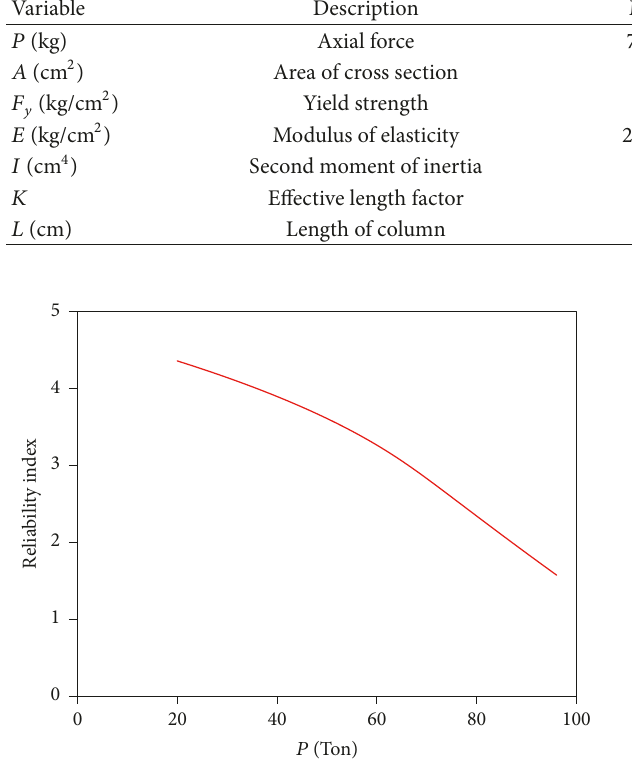
Figure7:Reliabilityindexwithrespecttotheaxialcompressiveload of column example.